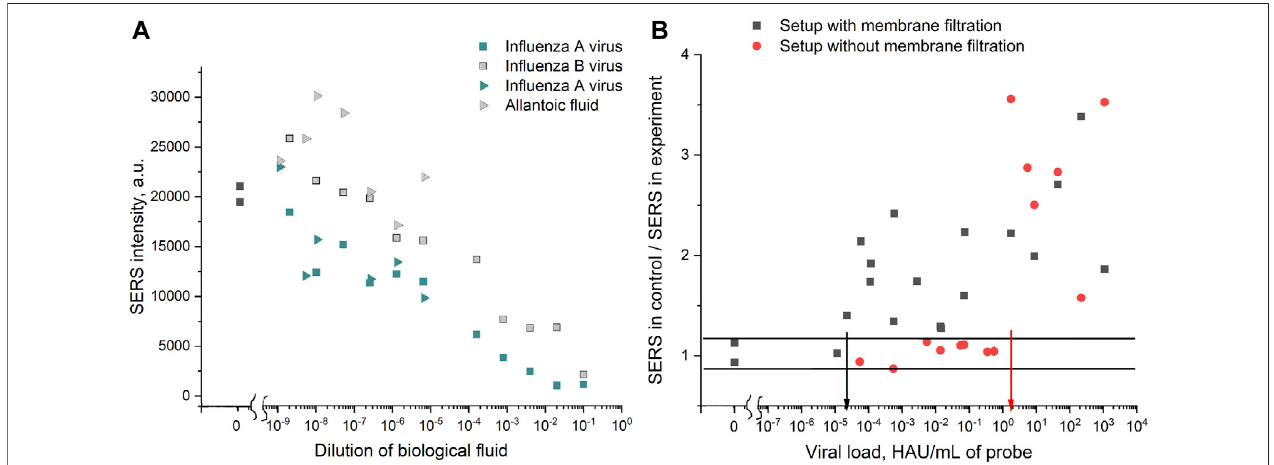
FIGURE 11 | SERS-based aptasensor for in fl uenza A virus. (A) Absolute SERS signals for different dilutions of the in fl uenza A virus, in fl uenza B virus, or allantoic fl uid.Dilution10 0 corresponds totheundilutedsample.Theexperiments performedsimultaneouslyareshownwiththesame symbolsbutindifferentcolors. (B) Relative SERS signals obtained by dividing the SERS signal in the control experiment by the SERS signal in the sample with the in fl uenza A virus. Setups with and without membranes are compared. Arrows indicate the limits of detection for each setup. The relative mean standard deviation for the measurement was 15%; thus, the samples with the ratio in the range 0.85 – 1.15 were interpreted as non-detectable